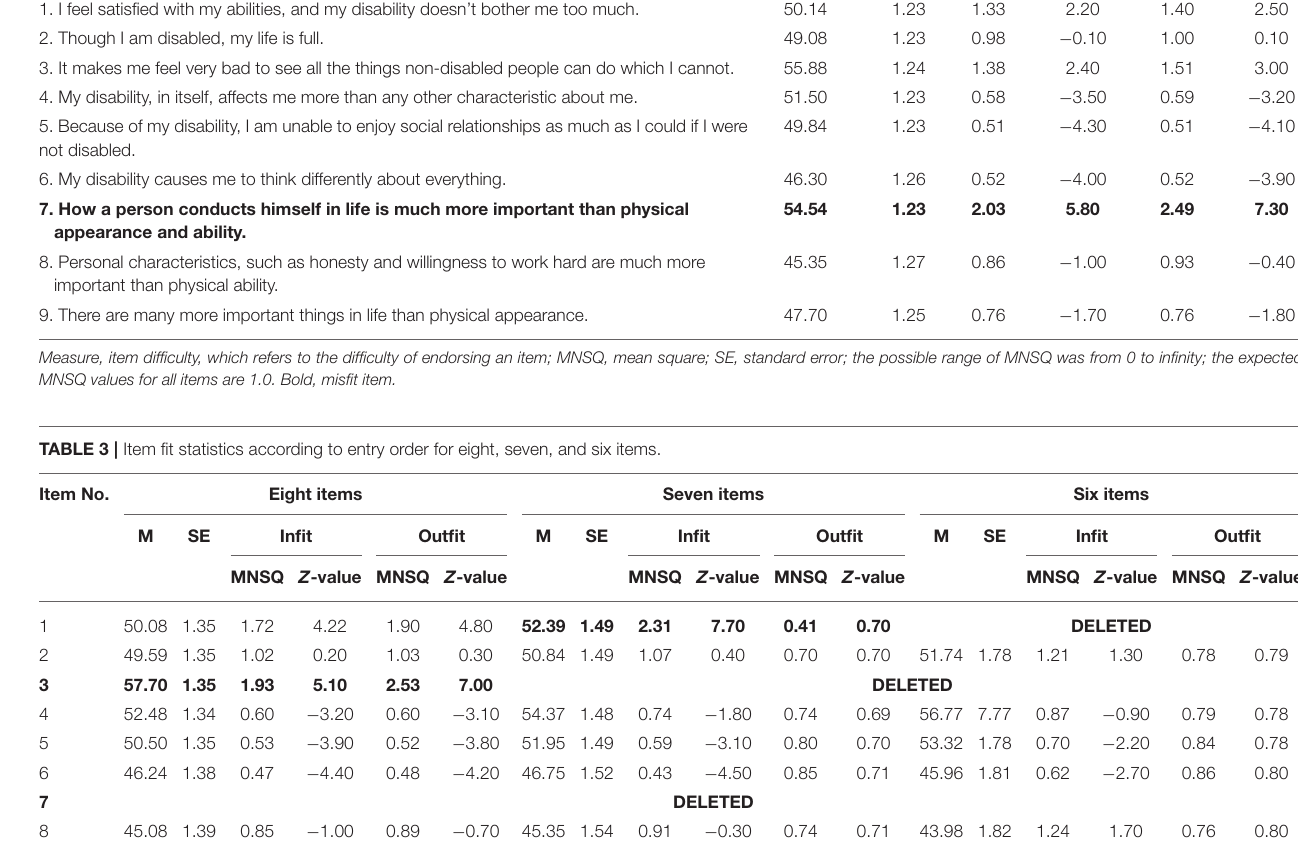
Table 2 showed the item fit statistics according to entry